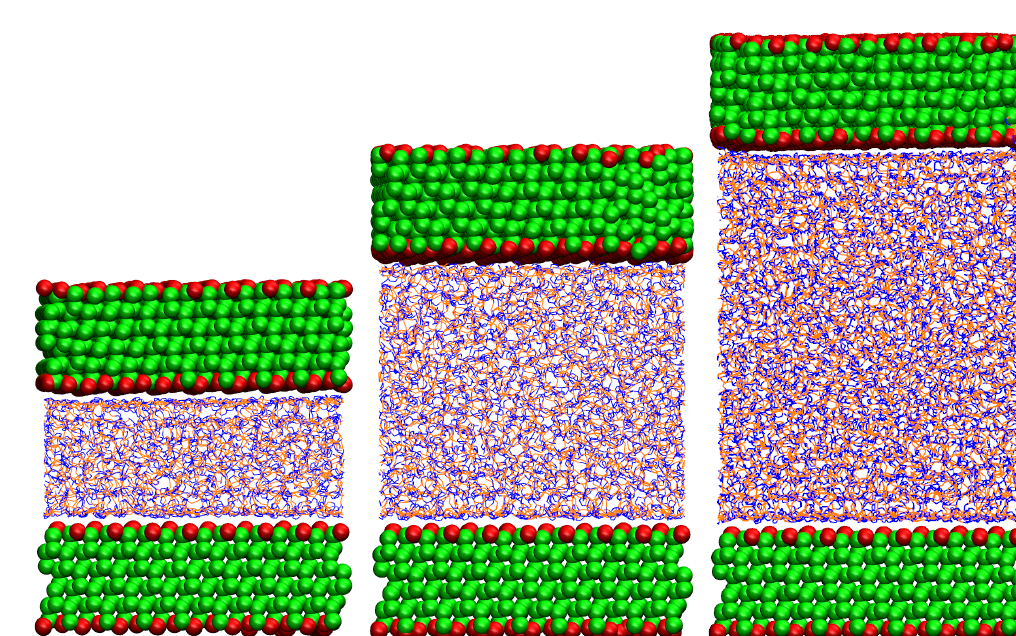
Figure 2. From left to right: systems l 1 , l 2 , l 3